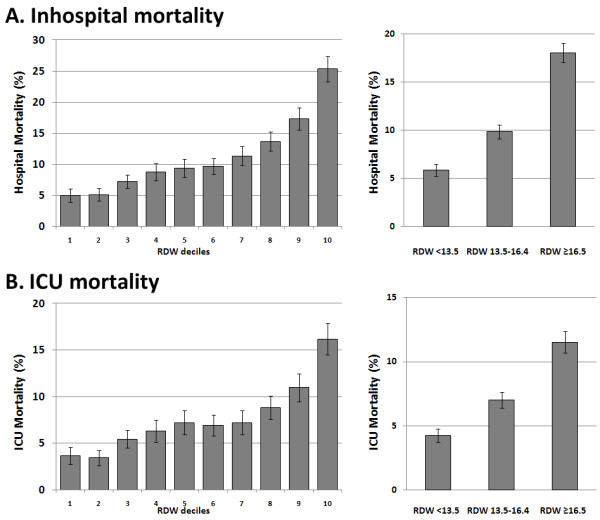
Mortality. Hospital mortality (A) and ICU mortality (B) within RDW deciles (left panel) and RDW categories (right panel).